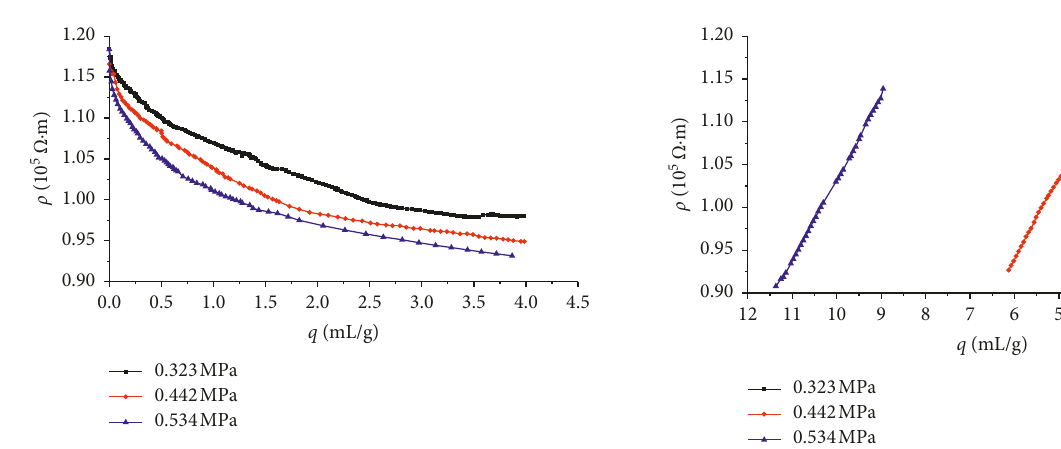
Figure 3: Resistivity of coal vs. change of gas content during continuous adsorption.